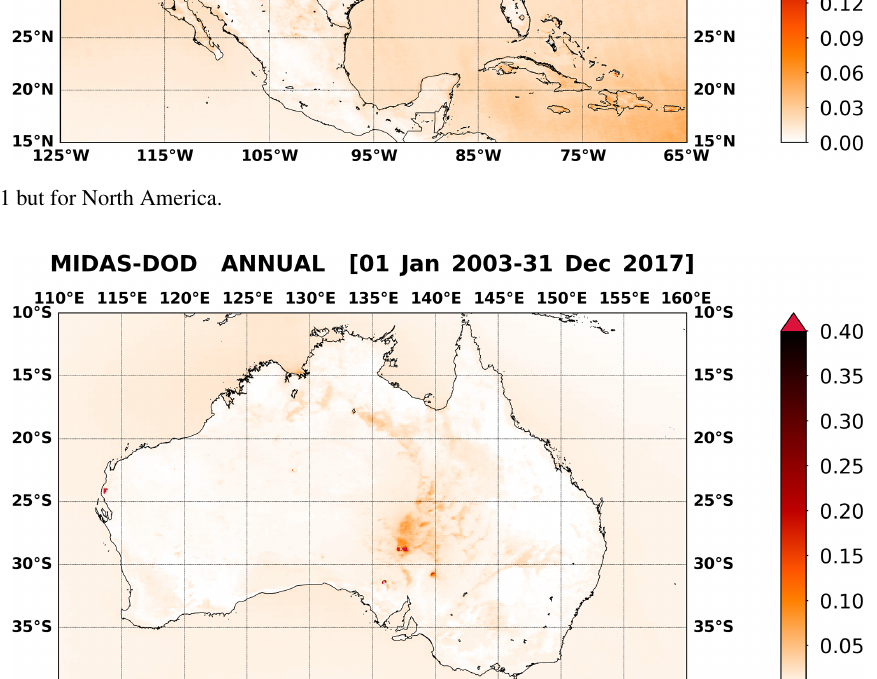
Figure 7. As in Fig. 1 but for